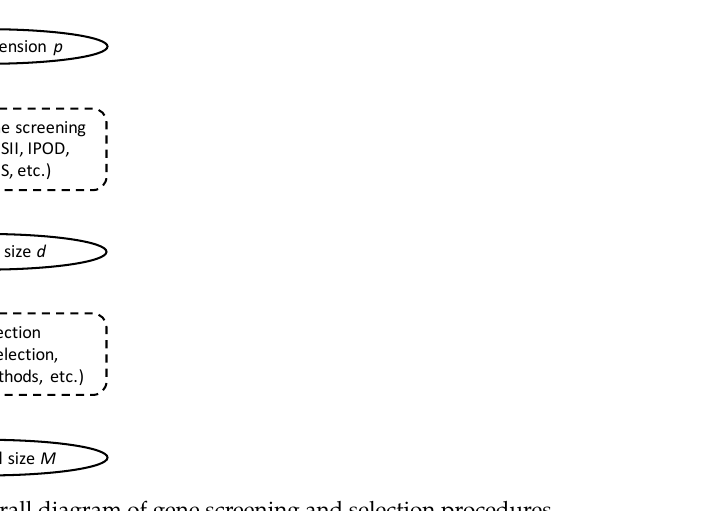
Figure 1. Overall diagram of gene screening and selection